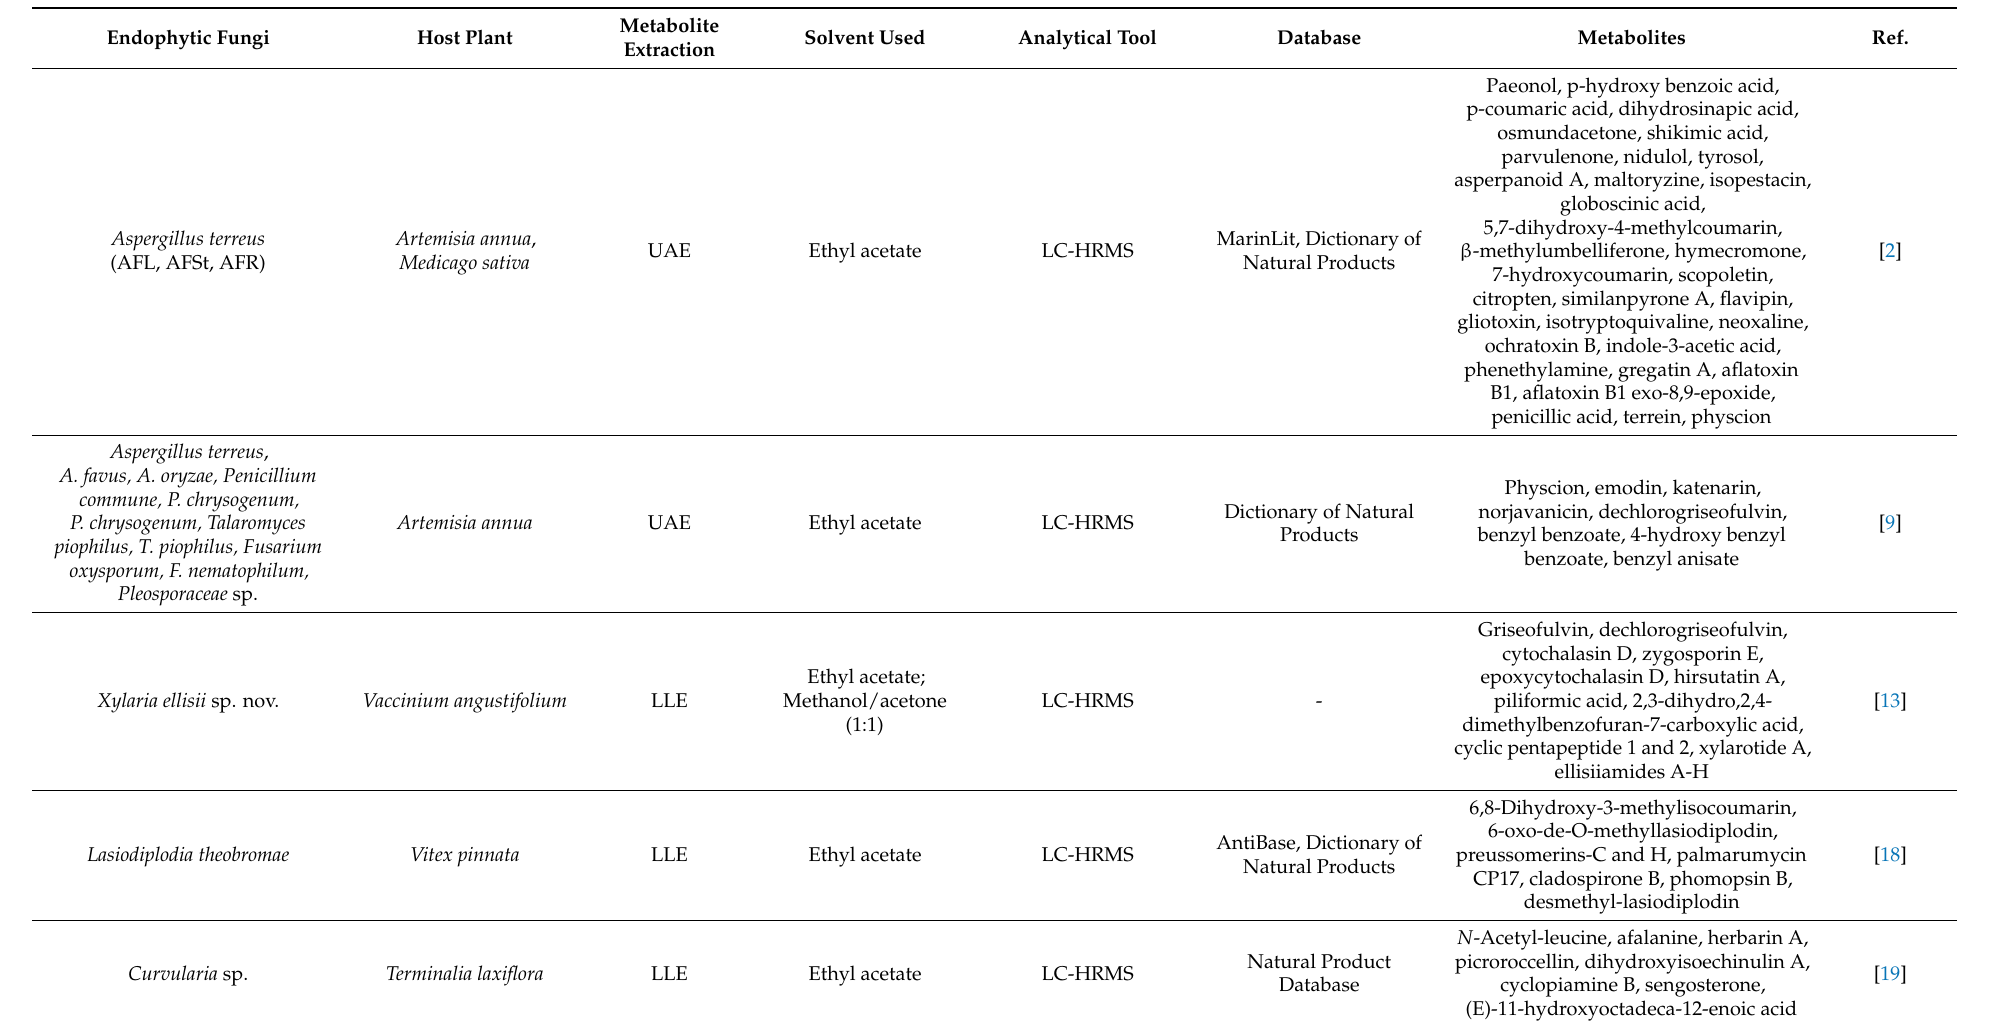
Table 1. Metabolites identification in endophytic fungi via LC-HRMS- and NMR-based